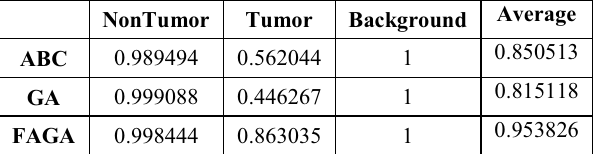
Table 5. Performance comparison using fourth image in terms of